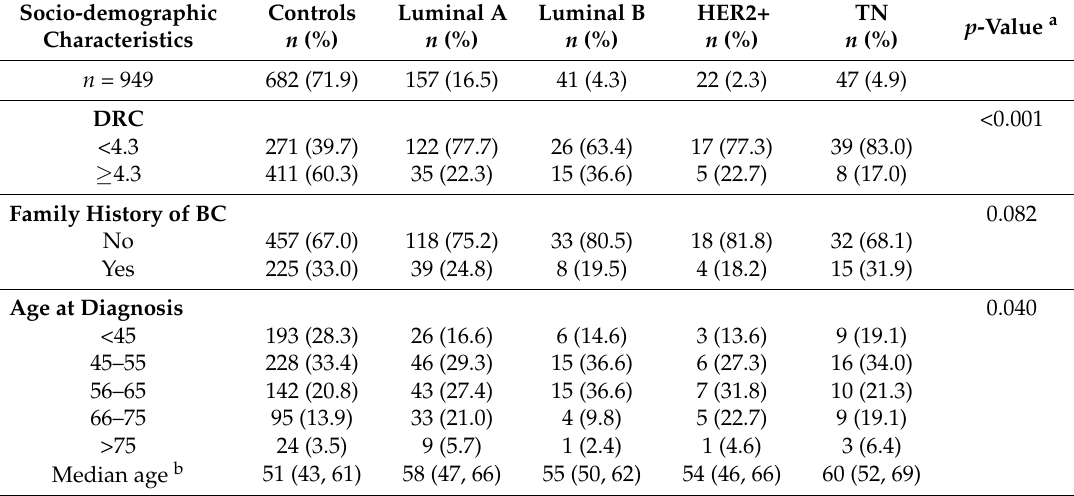
Table 1. Socio-demographic and risk factor distribution by molecular breast cancer subtype.